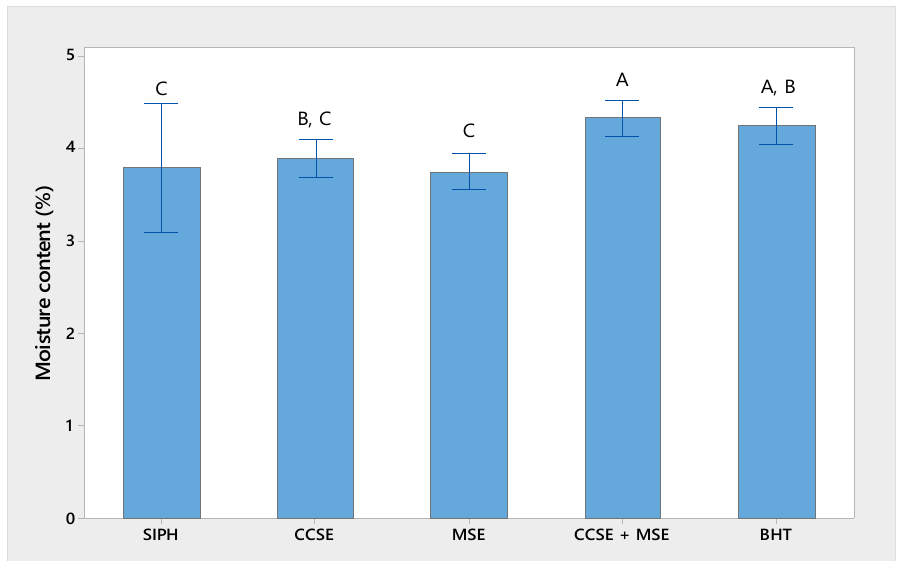
Figure 1. Moisture content (%) of sacha inchi, P. huayllabambana oil microencapsulated (SIPH). Different capital letters indicate significant differences ( p ˂ 0.05).